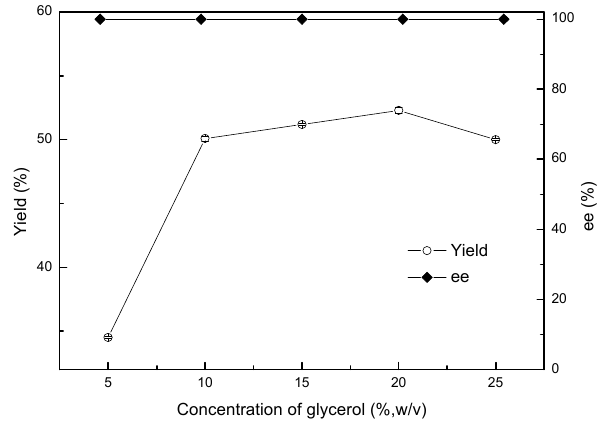
Figure 5. E ff ect of di ff erent glycerol addition on the asymmetric Figure 5. Effect of different glycerol addition on the asymmetric reduction.